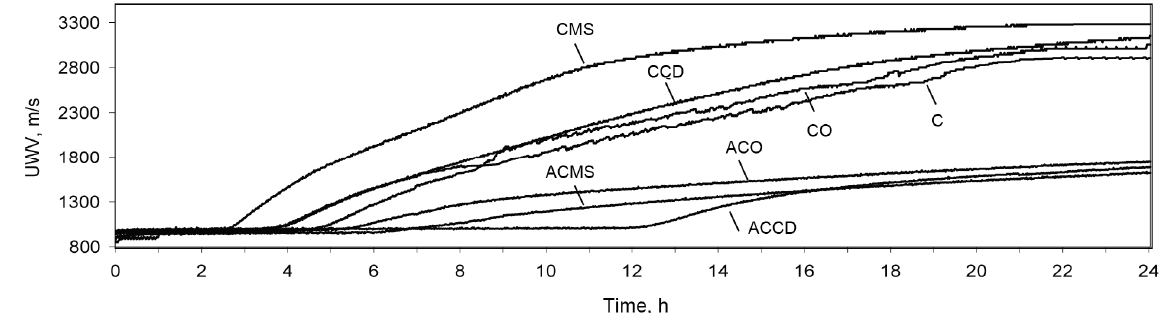
Fig. 5. The variation of UWV in C, CP and ACP